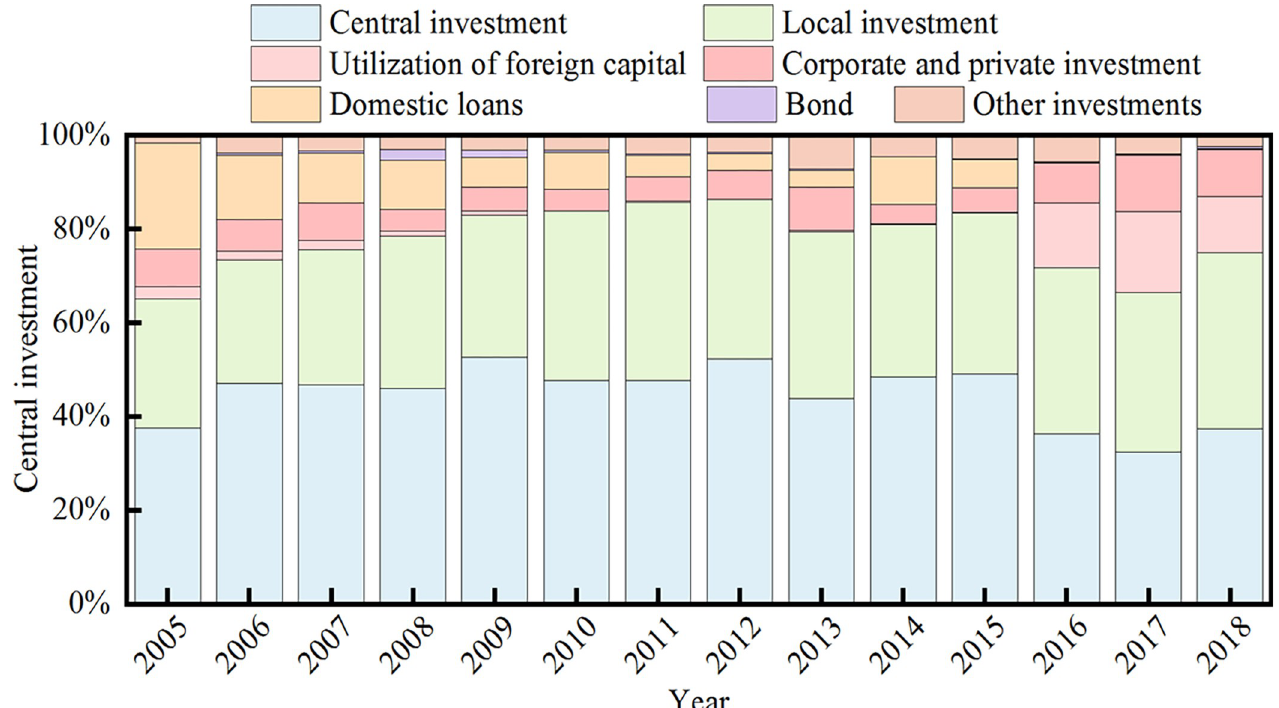
Fig 2. Distribution of agricultural water salvation investment sources in the Eastern region.